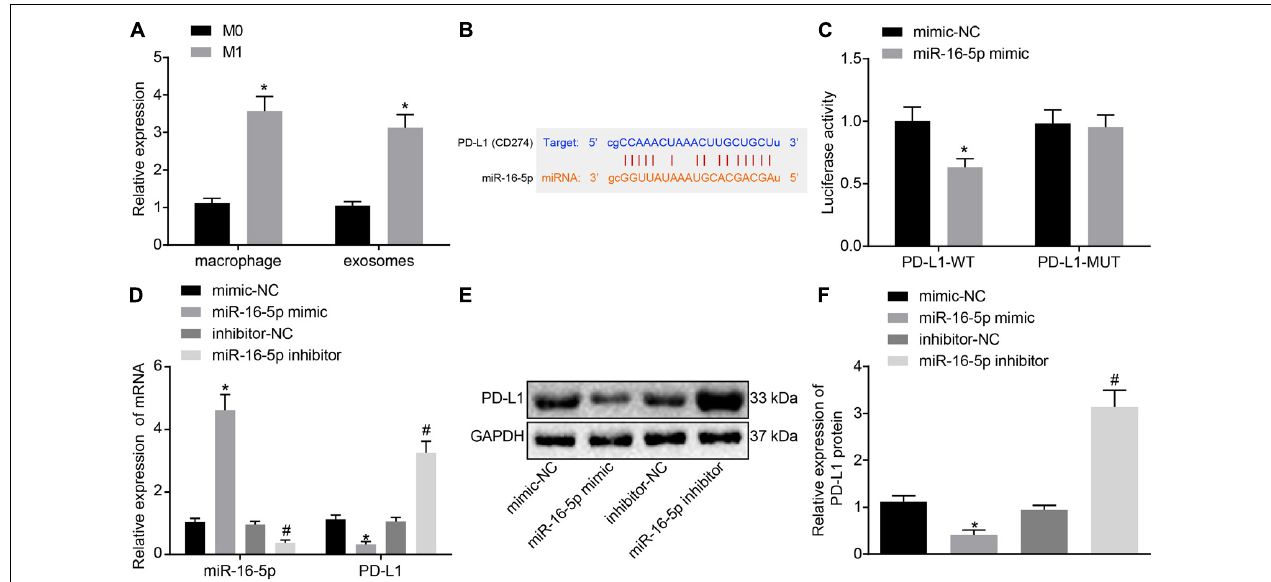
FIGURE 4 | Exosomes derived from M1 macrophages harboring miR-16-5p repress PD-L1 expression. (A) RT-qPCR of miR-16-5p expression in unpolarized M0-, M1-polarized macrophages and their secreted exosomes. (B) Starbase (http://starbase.sysu.edu.cn) prediction of binding site between miR-16-5p and PD-L1. (C) Dual luciferase reporter gene assay verification of the target relationship between miR-16-5p and PD-L1. (D) RT-qPCR of PD-L1 expression in macrophages treated with miR-16-5p mimic and miR-16-5p inhibitor. (E) Western blot analysis of PD-L1 expression in macrophages treated with miR-16-5p mimic or miR-16-5p inhibitor. (F) Statistic analysis of PD-L1 expression in macrophages treated with miR-16-5p mimic or miR-16-5p inhibitor; mimic-NC: negative control for miRNA mimic; inhibitor-NC: negative control for miRNA inhibitor. * p < 0.05 versus unpolarized M0 macrophages and its secreted exosomes or cells treated with mimic-NC; # p < 0.05 compared to cells treated with inhibitor-NC. Measurement data representative of three independently conducted experiments expressed as the mean ± standard deviation. Comparisons between two groups are analyzed by non-paired t test.